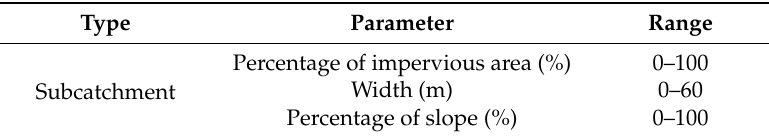
Figure 10. Calibration and validation of 2010 and 2011 data. Table 2. Summary of calibration parameters.